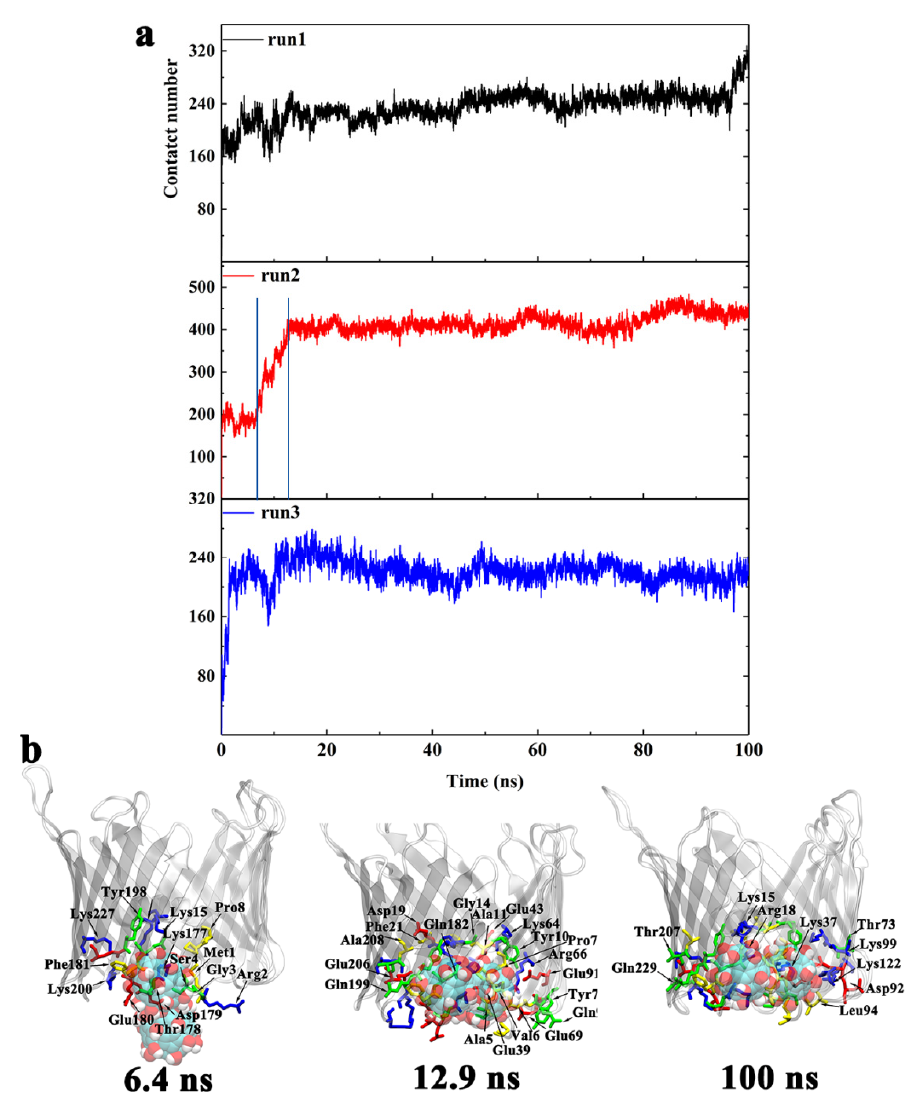
Figure 6. ( a ) The evolution of the total number of atomic contacts between hVDAC1 and Gd@C 82 (OH) 22 molecules that penetrated from the IM for runs 1–3. The blue line represents key time points of the protein–nanoparticle interactions. ( b ) The binding conformations of Gd@C 82 (OH) 22 to hVDAC1 at key time points corresponding to ( a ) as well as the final conformation. The key residues that contact Gd@C 82 (OH) 22 are labeled and colored according to the residue type.